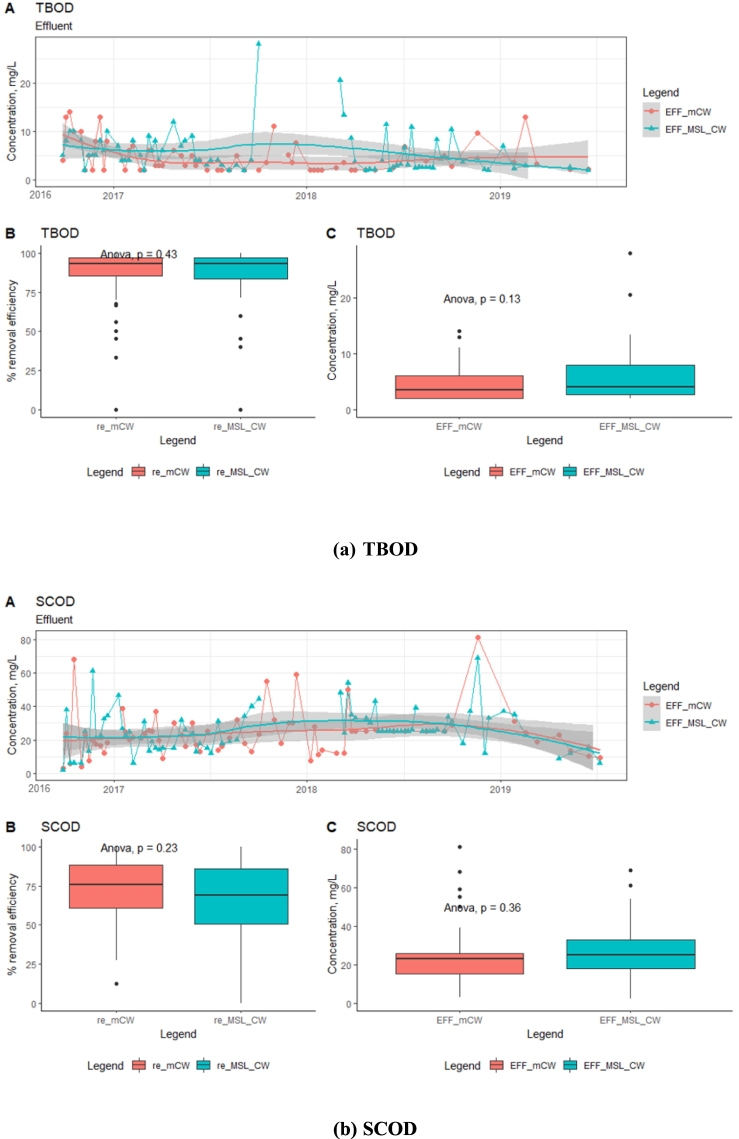
Time-series analysis of effluent concentrations and box plots (removal efficiency (re) and concentration (EFF)): TCOD, SCOD, TBOD, TSS.